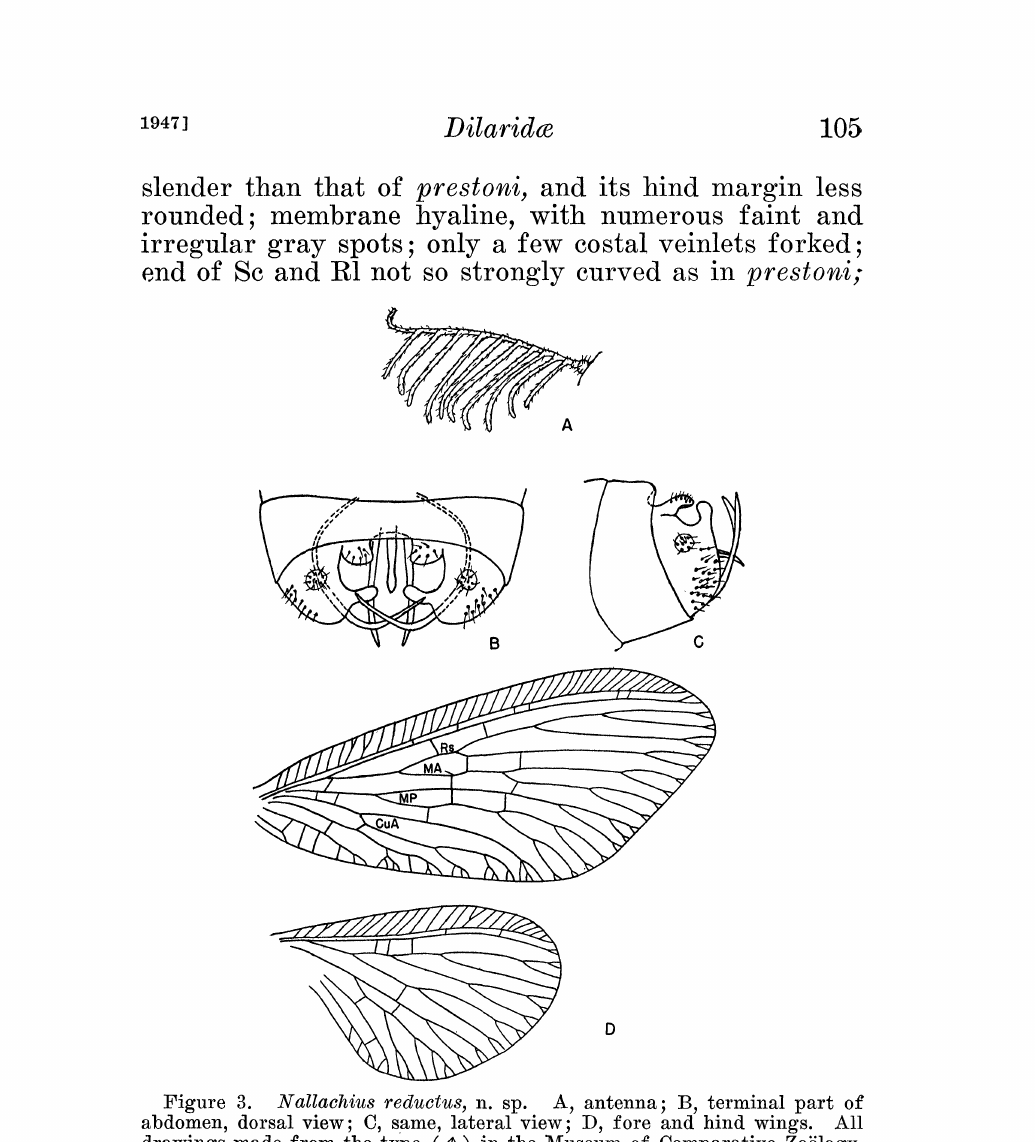
Figure 3. Nallachius reductus, n. sp. A, antenna; B, terminal part of abdomen, dorsal view; C, same, lateral view; D, fore and hind wings. All drawings made from the type in the Vluseum of Comparative